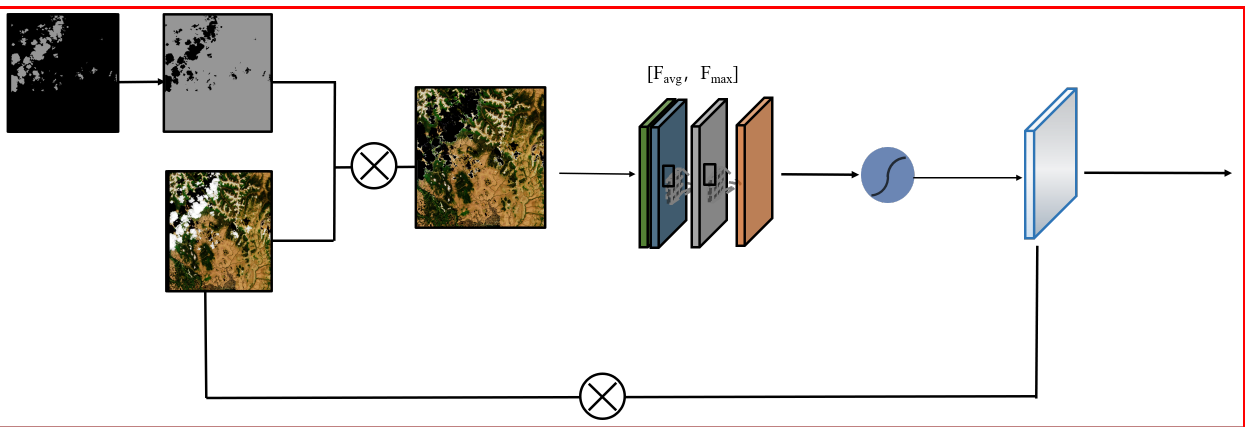
Figure 4. Schematic diagram of the structure of the attention module based on the region of interest.